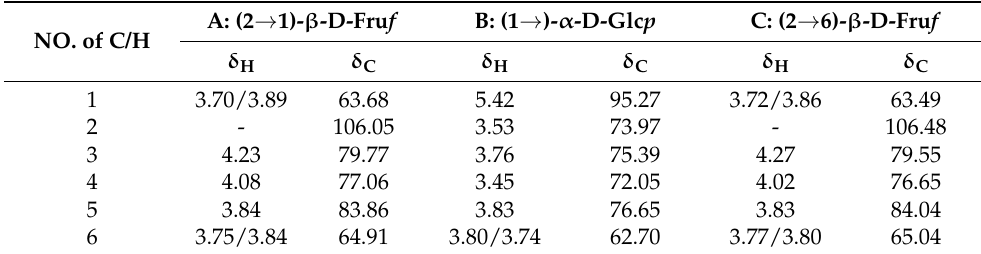
Figure 5. The 13 C ( A ), DEPT135 ( B ), HSQC/HMBC (blue/red signals) ( C ), and NMR spectra and possible structural formula ( D ) of the CPPs. Note: A represents (2 → 1)- β -D-Fru f residue, B represents (1 → )- α -D-Glc p residue, C represents (2 → 6)- β -D-Fru f residue. Table 4. The chemical shifts in the CPPs in the HSQC